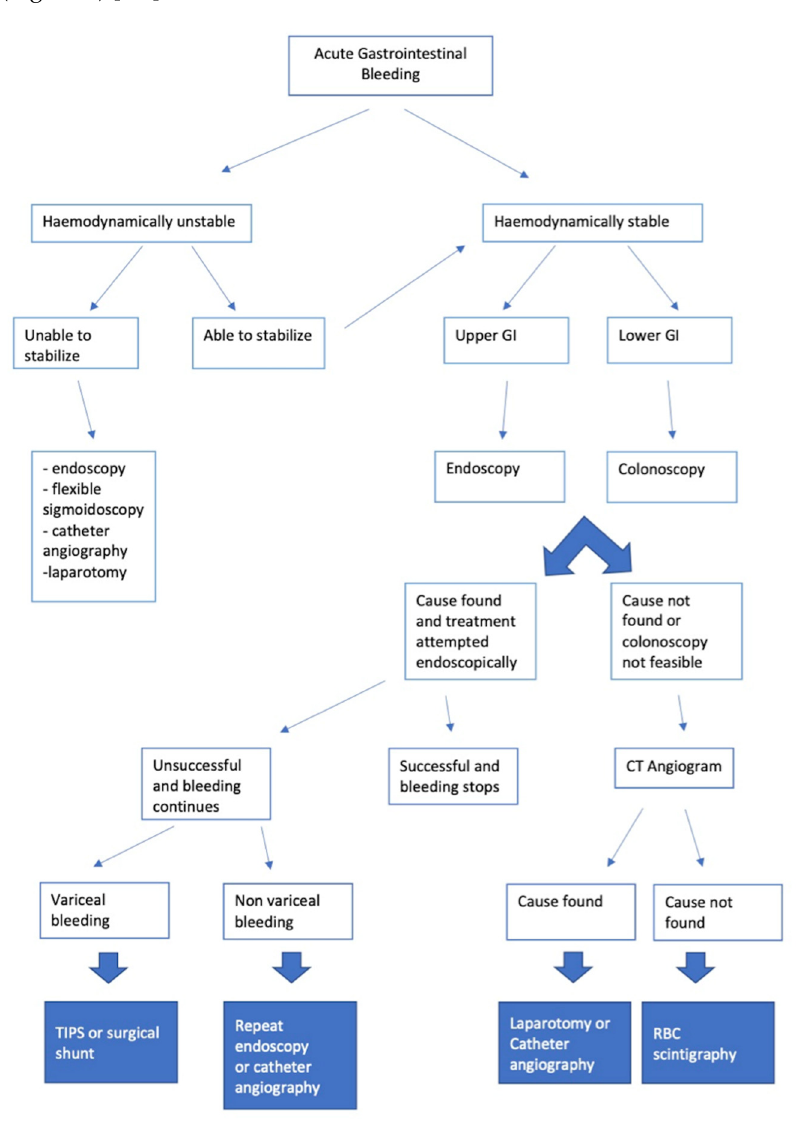
Figure 1. Therapeutic and diagnostic flow chart of a patient with gastrointestinal bleeding.